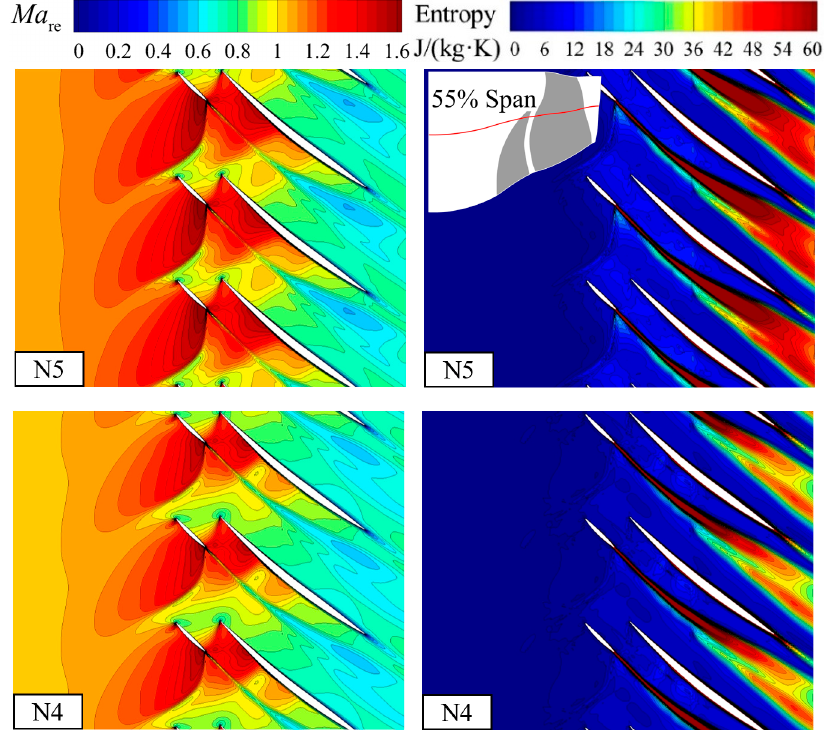
Figure 14. Ma re and entropy contour at 55% span of the tandem rotor.